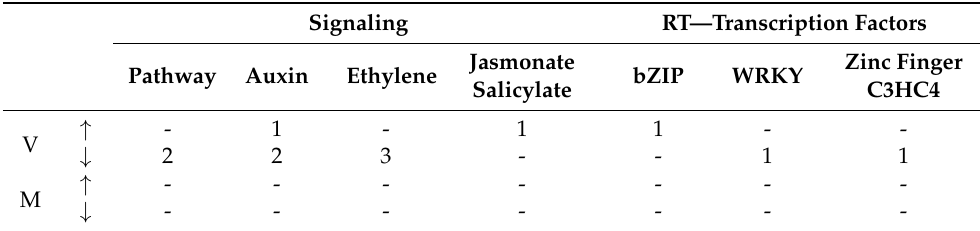
Figure 5. Functional category analysis of significantly regulated DEGs in the developmental stages véraison and full maturation. Gene expression values were obtained through RNA-Seq analysis and the DEGs included in these pie charts showed significant differences in expression at véraison and full maturation when comparing sustained deficit irrigation (SDI) and regulated deficit irrigation (RDI). Charts ( a , c ) — upregulated DEGs; ( b , d ) — downregulated DEGs. PM — primary metabolism; RT — regulation of transcription; RS — response to stress; SM — secondary metabolism. Table 4. Detailed analysis of the transcripts up- ( ↑ ) and downregulated ( ↓ ) in the functional catego- ries signaling and RT — transcription factors according to the results showed in Figure 4. “ Pathway ” in signaling is only represented by protein kinases.